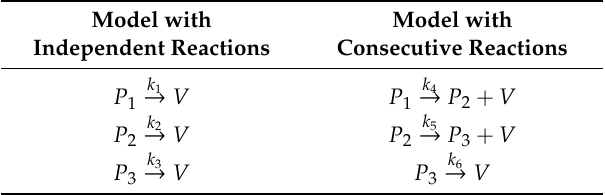
Table 5. ReactionsconsideredforchemicaldegradationofcrosslinkedPMMA,asdonebyDa Ros et al. [121]. Model with Model with Independent Reactions